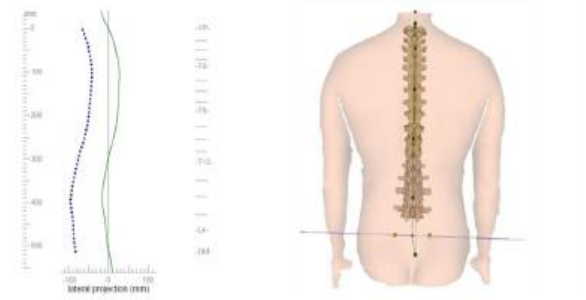
Figure 5. Reference measurement in standing position.